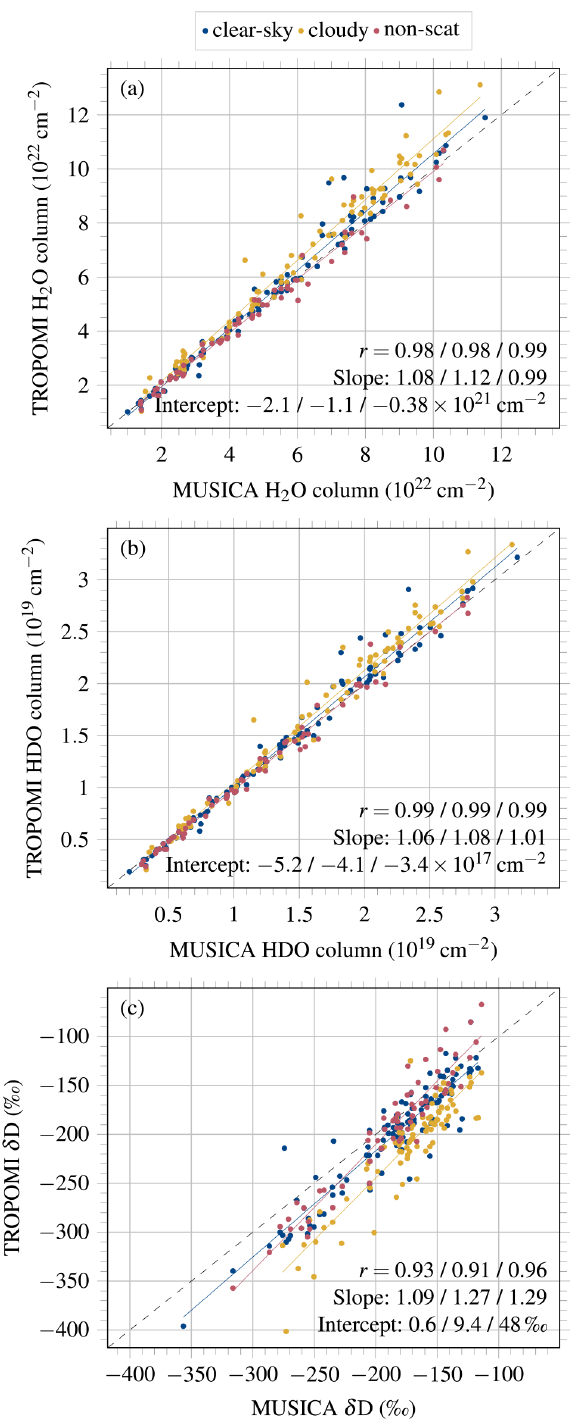
Figure 14. Correlations of TROPOMI observations against cor- rected MUSICA-NDACC measurements of (a) H 2 O columns, (b) HDO columns and (c) a posteriori δ D for clear-sky scenes (blue), cloudy scenes (yellow) and the non-scattering retrieval (red) at Karlsruhe. The coloured lines represent linear fits and the dashed line denotes the one-to-one line.